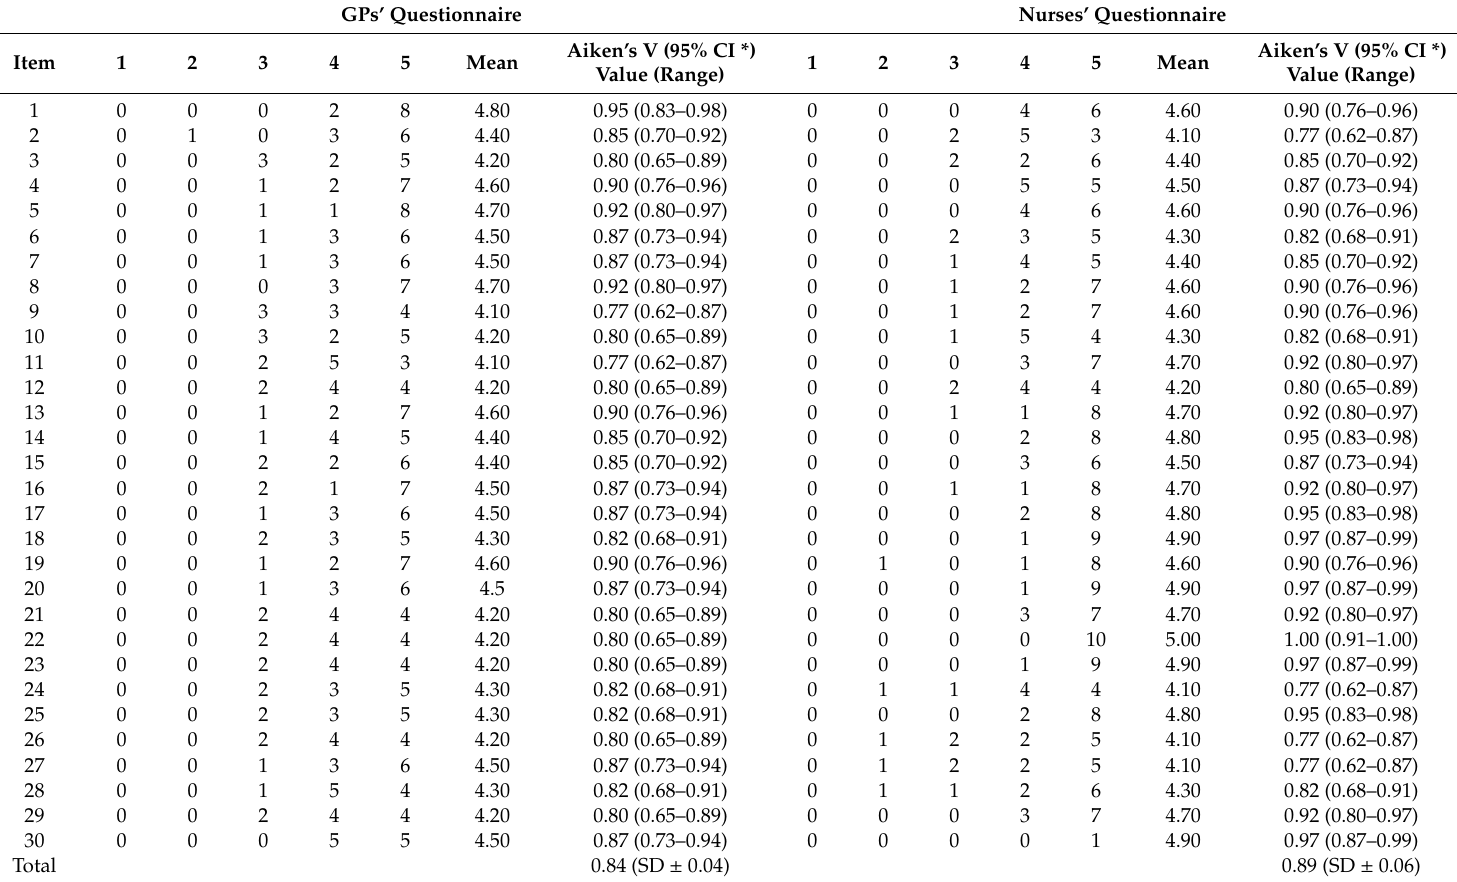
Table 6. The mean and Aiken’s V coe ffi cient score for all the thirty items o ff ered by the ten